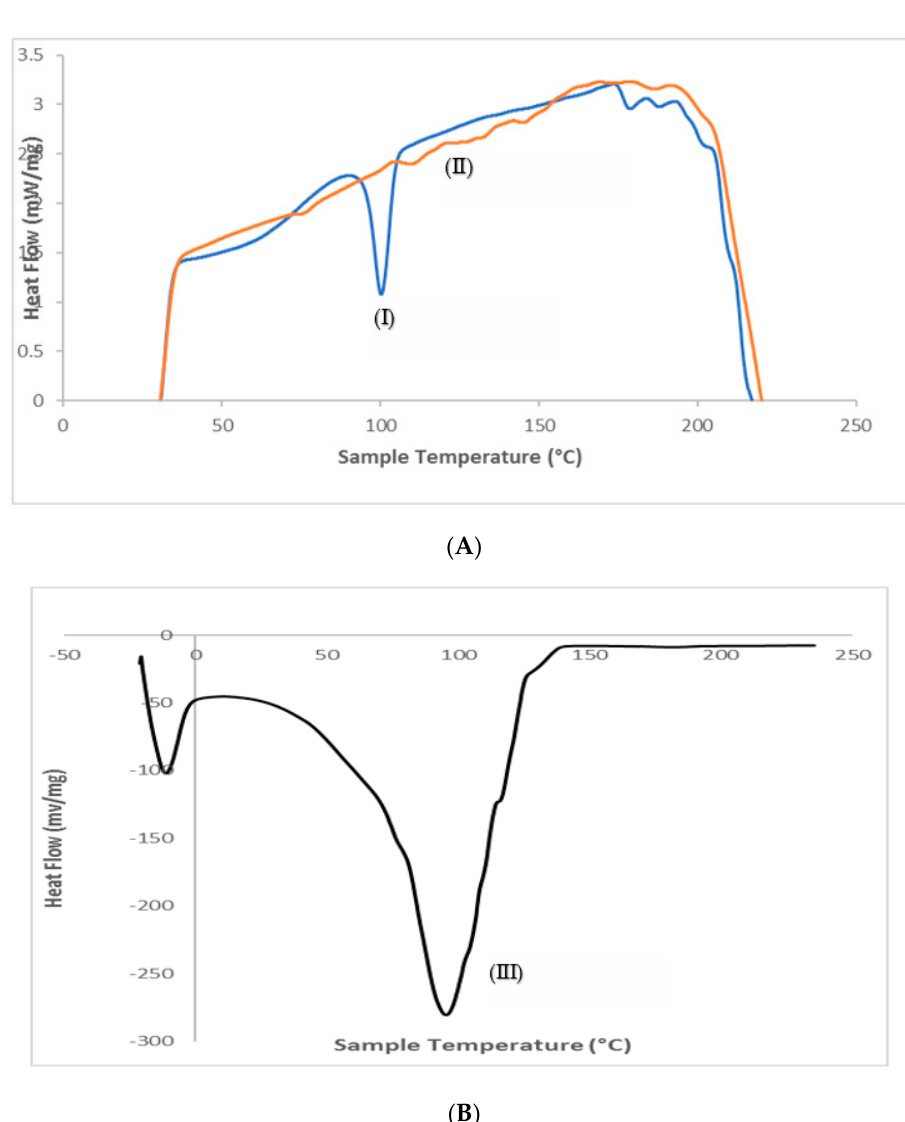
Figure 3. DSC thermograms of ( A ) (I) pure valsartan powder, (II) physical mixture, and ( B ) (III) optimized VLT-ETH formulation.